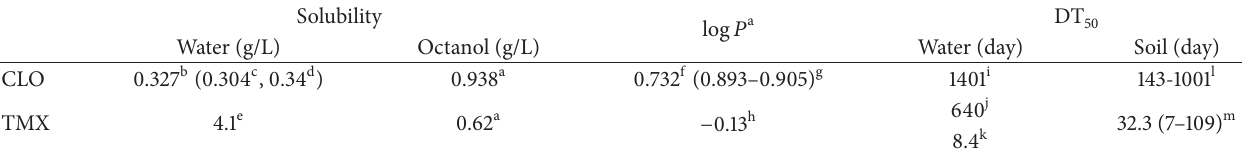
Table 4: Physicochemical constants of CLO and TMX [35,